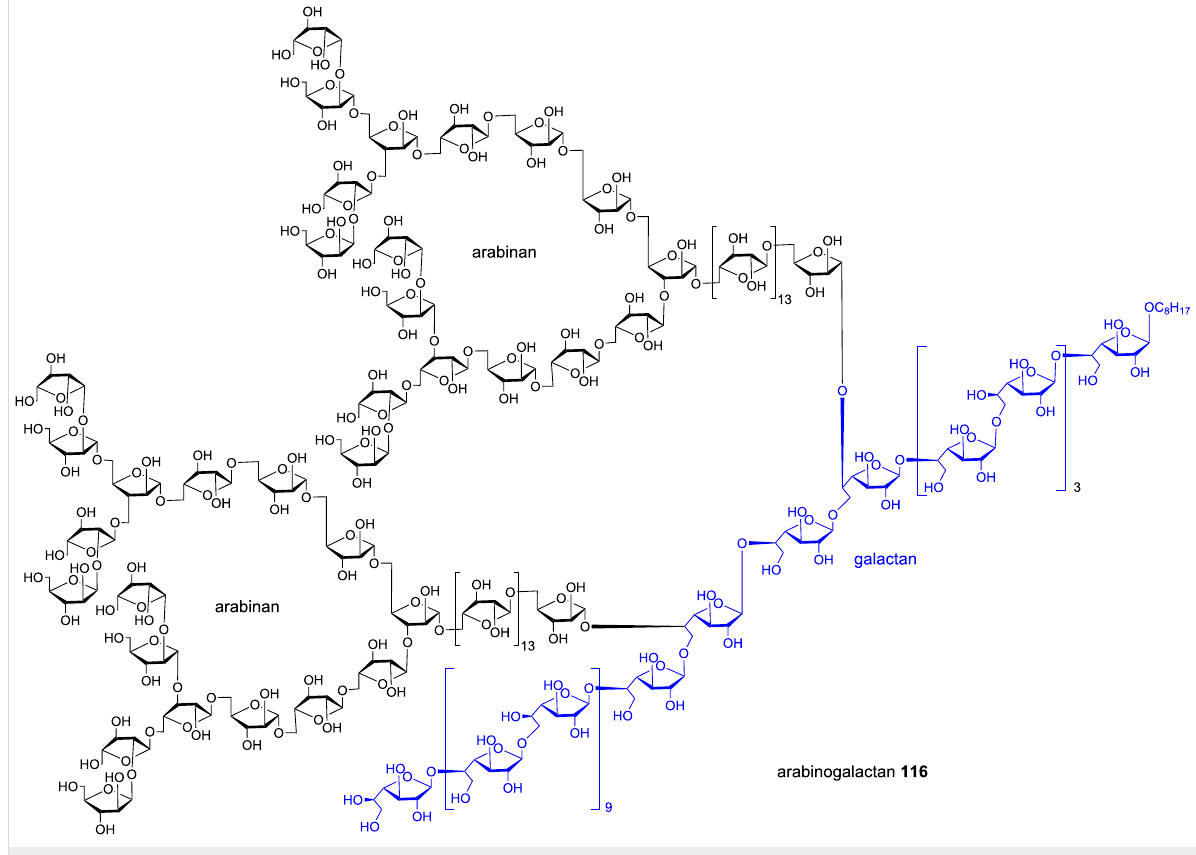
Figure 4: Structure of mycobacterial arabinogalactan 116 .